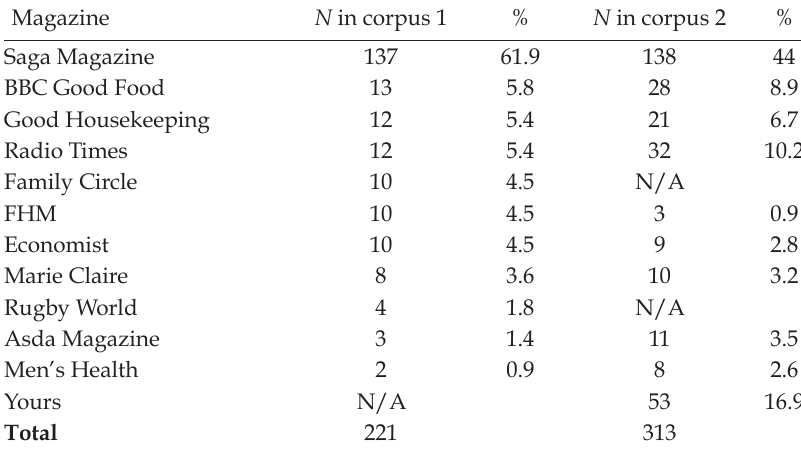
Table 1. Distribution of adverts across the